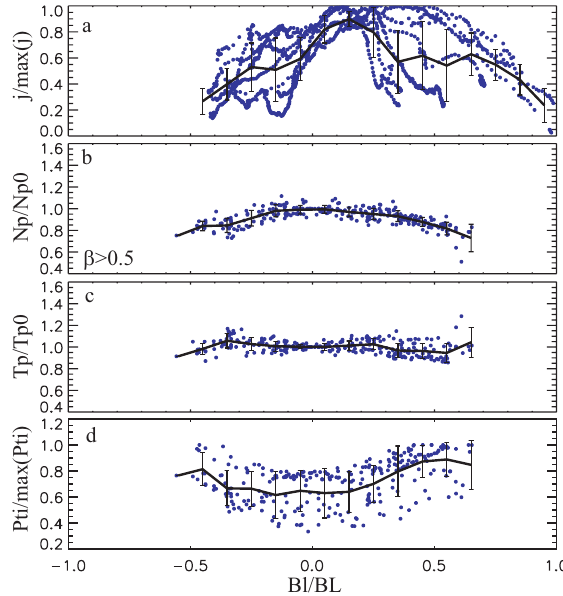
Fig. 7. Same as in Figs. 5 and 6 for class III current sheets.